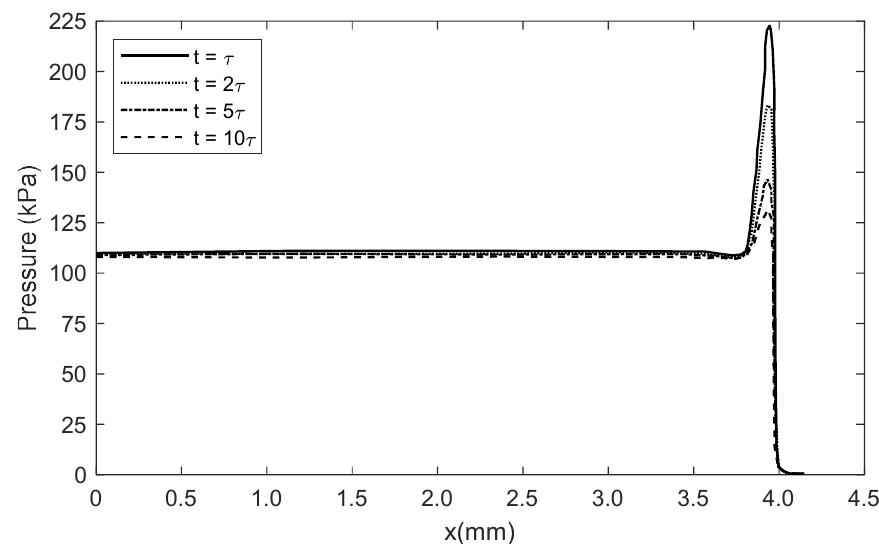
Figure 5. Measured axisymmetric contact pressure distribution (normal load of 5.8 N).